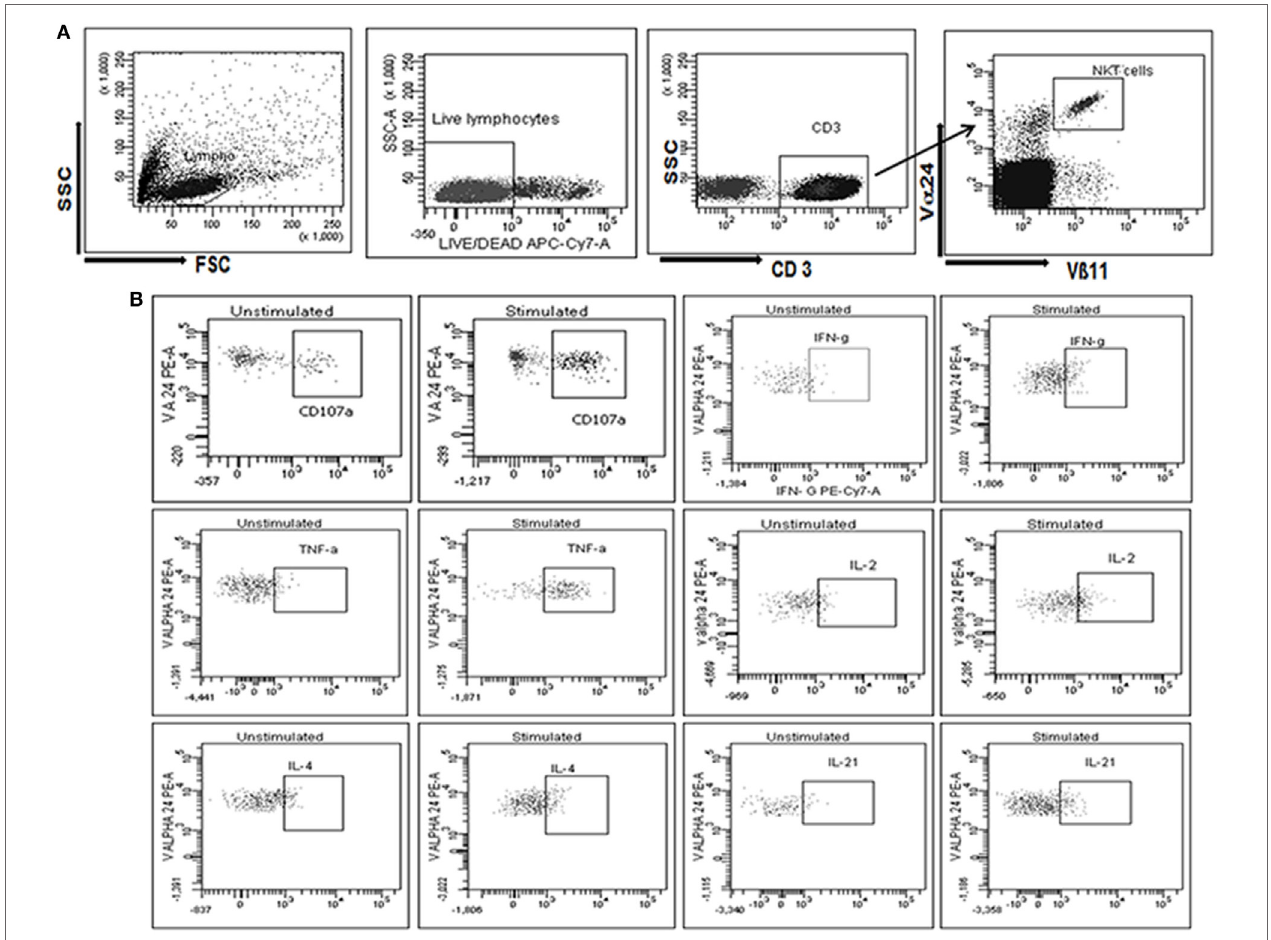
FigUre 1 | Gating strategy used to assess the identification and functional characterization of invariant natural killer T (iNKT) cells. (a) Initially, cells were gated on SSC and FSC followed by gate on live CD3 + T cells population (stained with violet amine reactive dye to identify live cells). The live CD3 + T cells further gated to identify iNKT cells as CD3 + , V α 24 + , and V β 11 + . (B) iNKT cells were further gated to assess the secretion of cytokines, such as IFN- γ , TNF- α , IL-2, IL-4, and/or IL-21 and CD107a expression at unstimulated and stimulated iNKT cells with α -GalCer ( B 1–12